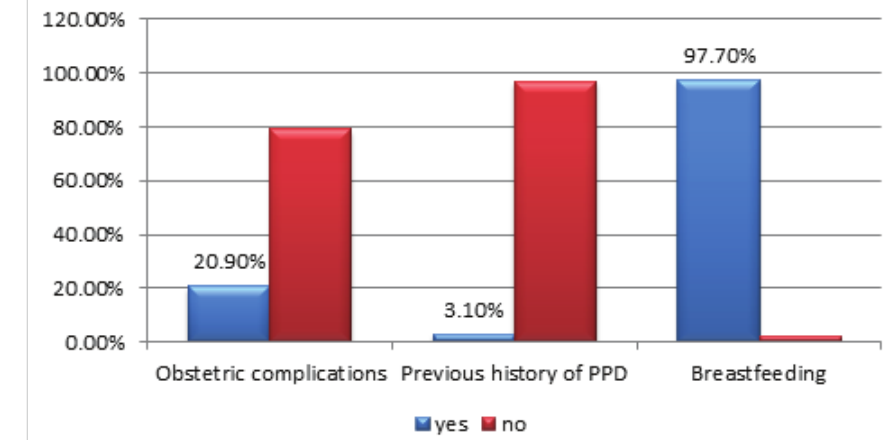
Figure 1: Percentages of mothers’ obstetric complications, history of PPD, and breastfeeding status, who were screened for PPD at the Saad Abueleella and Dream International Hospitals; n = 129.